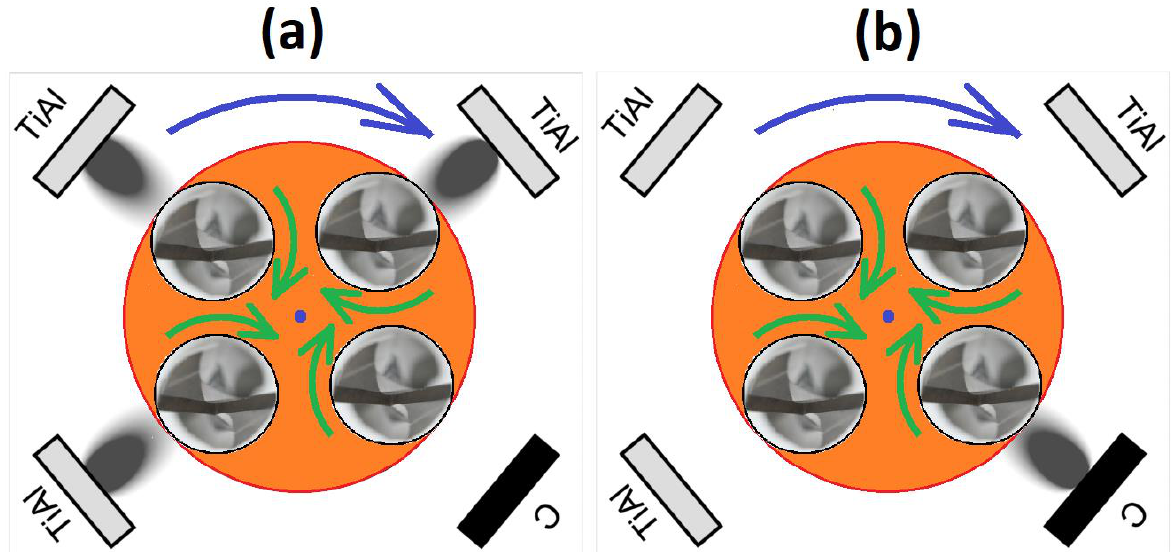
Figure 3. Configurations of the targets for deposition of “TiAlN” ( a ) and “a - CN layers” ( b ), which compose the double “TiAlN/a - CN” coating.